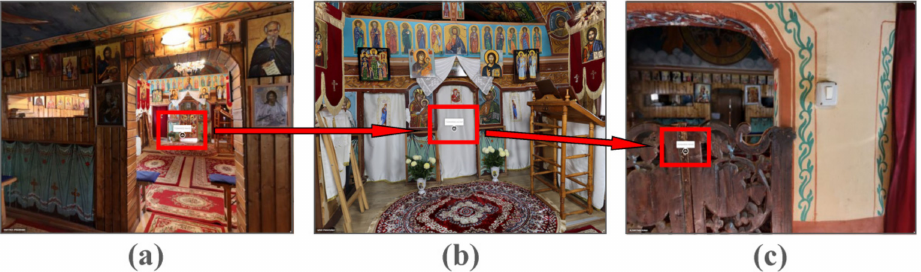
Figure 9. Interactive viewing of the panoramas inside the monuments by means of pop-up buttons, supplied with the function of guiding the visitor to the site through the individual rooms; ( a )—panorama of the narthex of the wooden church from Campus I of the University of Oradea; ( b )—panorama of the nave of the same monument; and ( c )—panorama of the altar of the same monument.